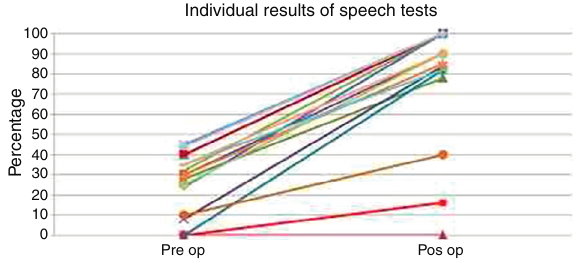
Individual results of speech tests: comparison of preoperative versus postoperative tests (as a